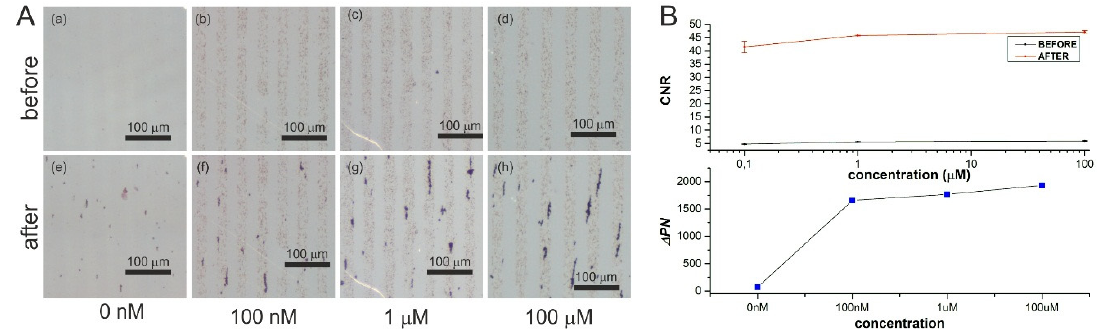
Figure 5. ( A ) Optical micrographs of some of the gold chips for streptavidin detection before and after magnetic signal amplification; ( B ) The calculated CNR and ∆ PN using the images in ( A ). Values are mean ± standard error of the mean.